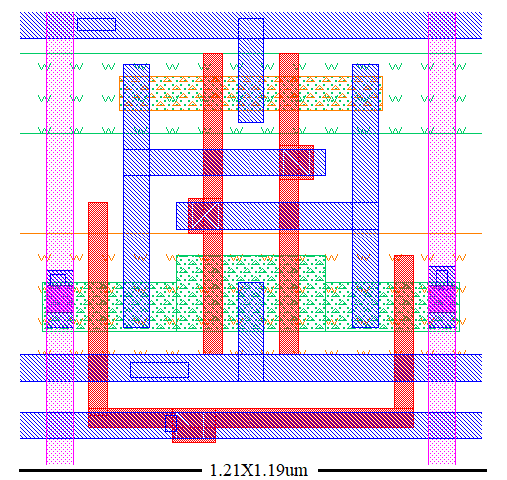
Figure 16. 6T SRAM cell layout according to the required sizing